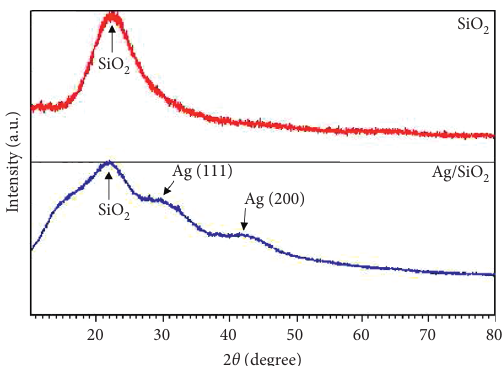
Figure 4: XRD patterns of pure SiO 2 and the synthesized Ag/SiO 2 nanocomposite.